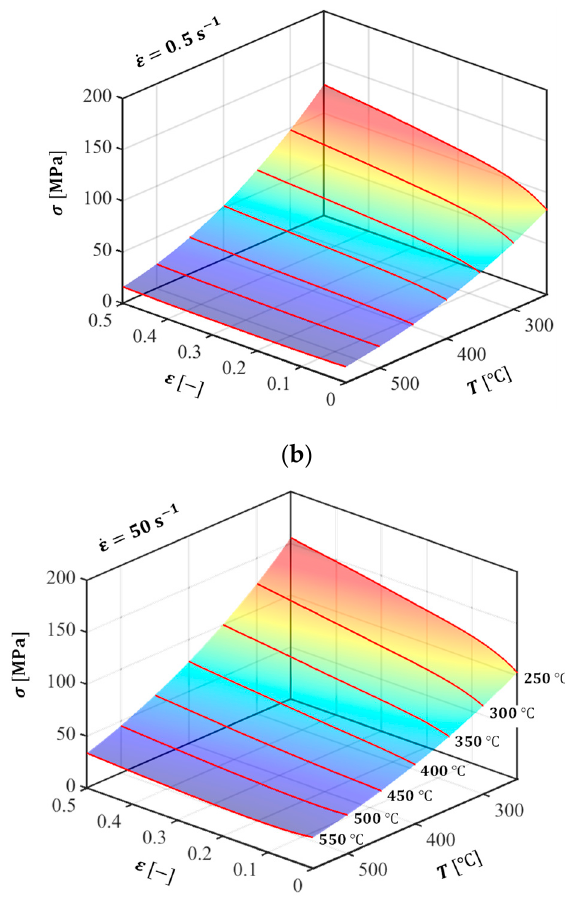
method: ( a ) schematic illustration; and ( b ) finite element discretization of the workpiece.